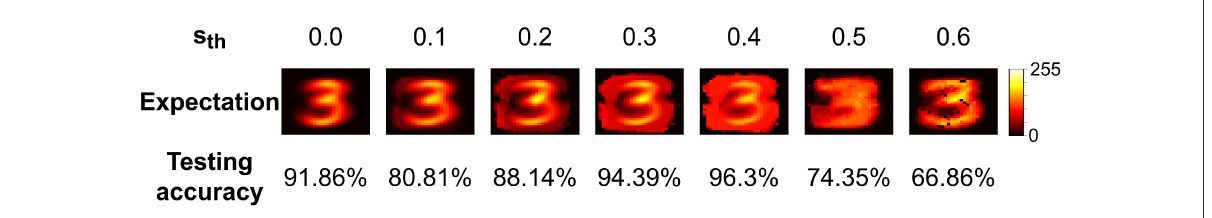
FIGURE8 A visualization of the expectation for the class 3 retrieved from the parameters stored by EDN during training on MNIST. A range of surprise thresholds, s th , are given to show how this effects the stored values and the subsequent effect on testing accuracy after a single epoch through the training